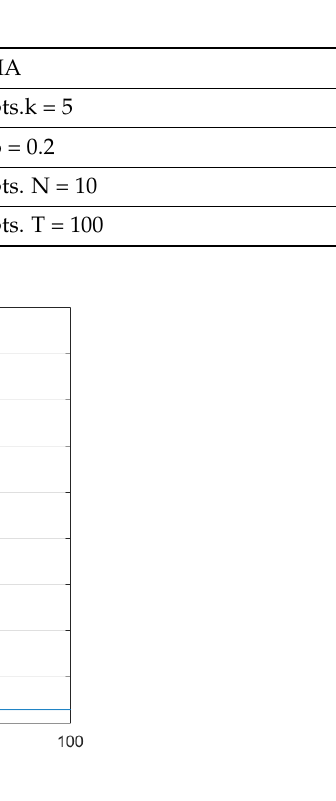
Figure 4. SMA convergence in terms of iterations and fitness value.